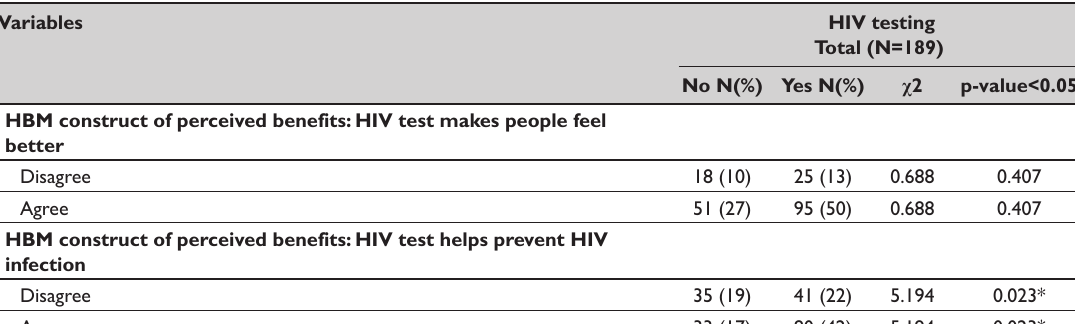
Table 3: Bivariate analysis of the association between health belief model (HBM) constructs, and HIV testing among students in a community